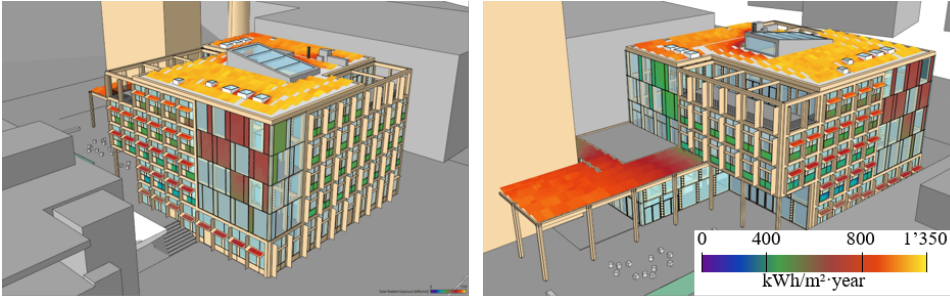
Figure 1. Cumulative annual irradiation of BIPV installation.